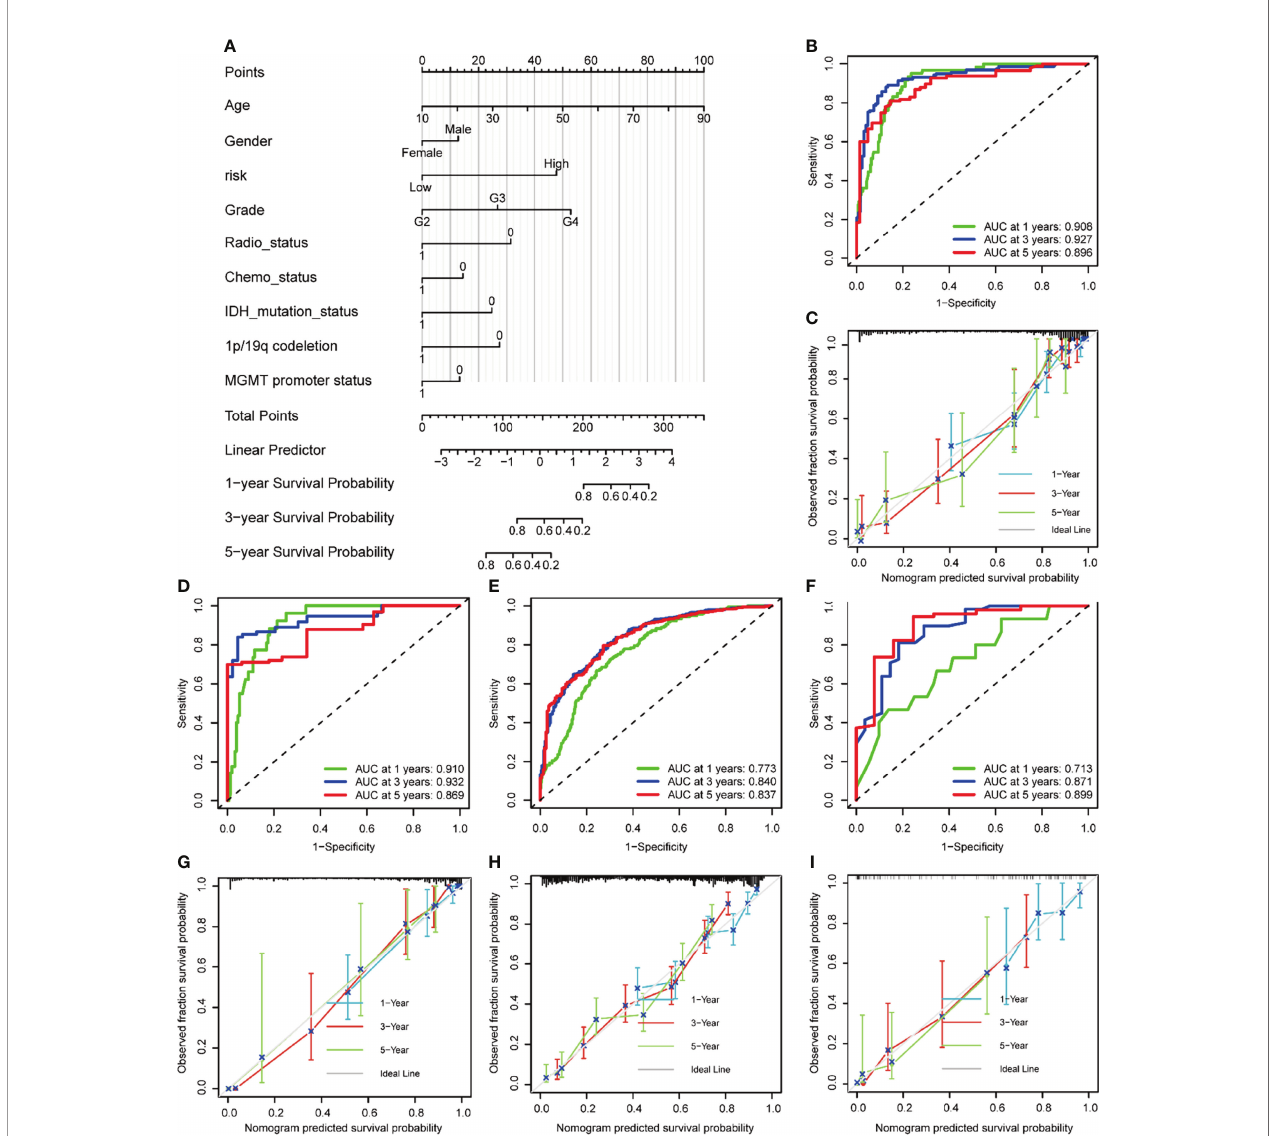
FIGURE 12 | Construction and validation of a nomogram to predict survival of patients with glioma. (A) Nomogram for predicting the 1-, 3-, 5-year survival of glioma patients in the training set. (B) ROC curves of the nomogram for predicting the sensitivity and speci fi city of 1-, 3-, 5-year survival in glioma patients in the training dataset. (C) Calibration curves of the nomogram for predicting 1-, 3-, and 5-year survival in glioma patients in the training dataset. (D-F) ROC curves of the nomogram for predicting the sensitivity and speci fi city of 1-, 3-, 5-year survival in glioma patients in the TCGA testing dataset(D), CGGA (E) , and Rembrandt (F) . (G- I) Calibration curves of the nomogram for predicting 1-, 3-, 5-year survival in glioma patients in the TCGA testing dataset (G) , CGGA (H) , Rembrandt (I)